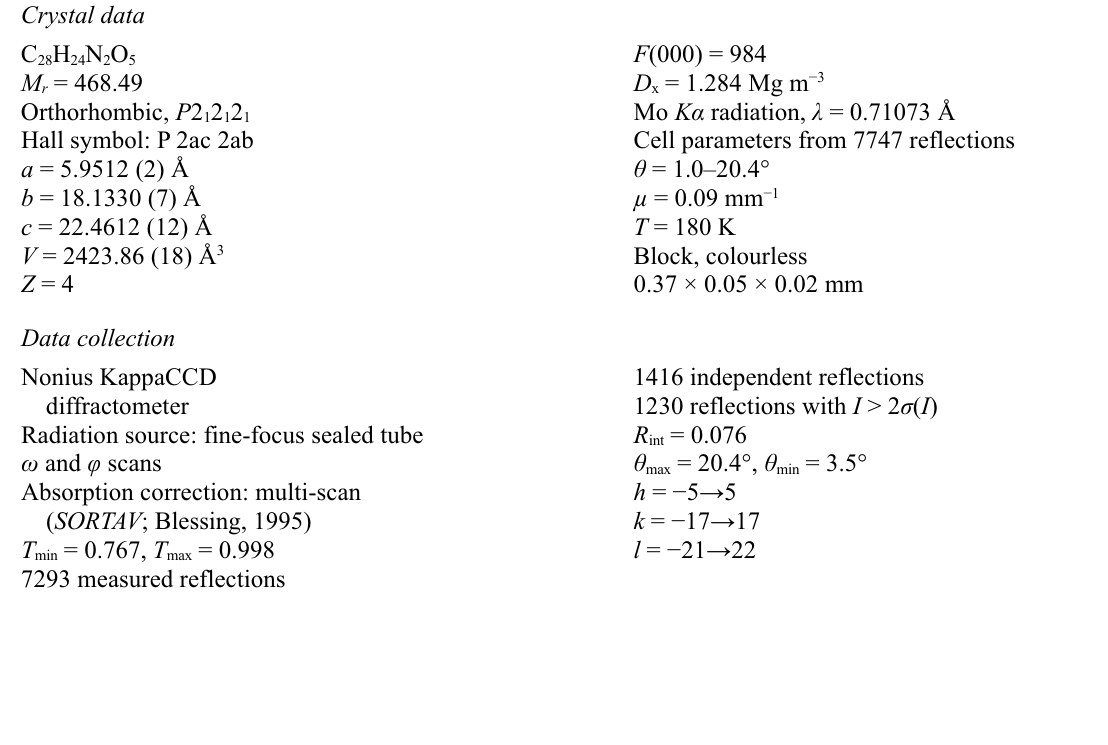
Summary of the synthetic procedure. CDI = 1,1′-carbonyldiimidazole, (DHQD) phthalazinediyl